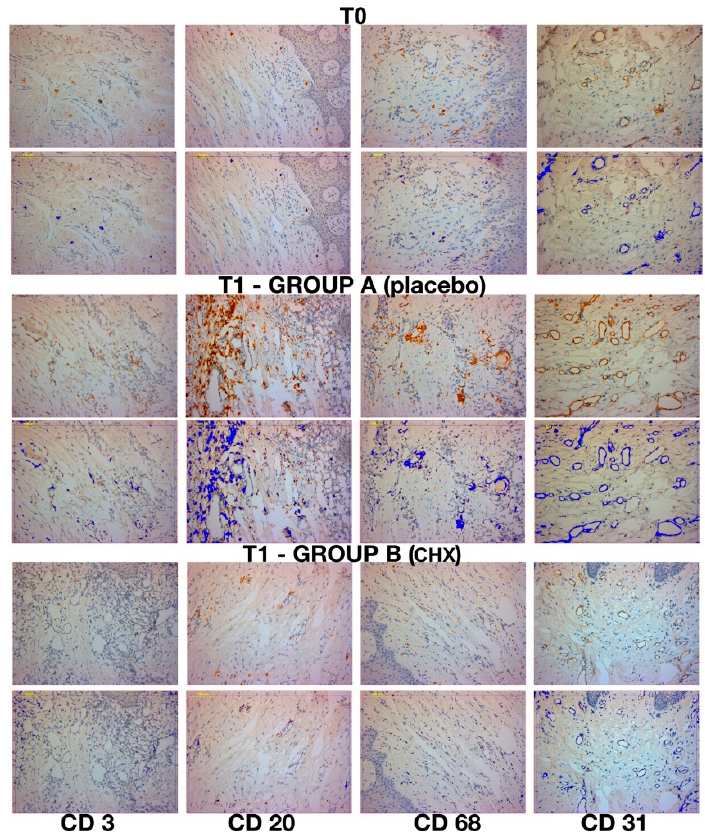
Figure 6. Immunohistochemical expression at T0, and T1 in group A and B (second surgical stage). Each of these images are in duplicates as one represent the immunohistochemical stain (strep-ABC 20× magnification) meanwhile the duplicate represents the image software analysis (and software analysis 20× magnification). In the first column CD3 expression (strep-ABC 20× magnification and software analysis 20× magnification). In the second column CD20 expression (strep-ABC 20× magnification and software analysis 20× magnification) are shown. In the third column CD68 expression (strep-ABC 20× magnification and software analysis 20× magnification) are shown. In the fourth column CD31 expression (strep-ABC 20× magnification and software analysis 20× magnification).